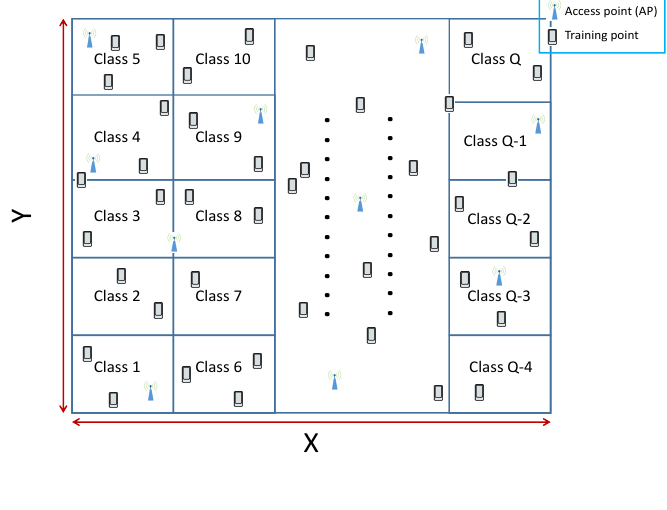
Figure 2. Region